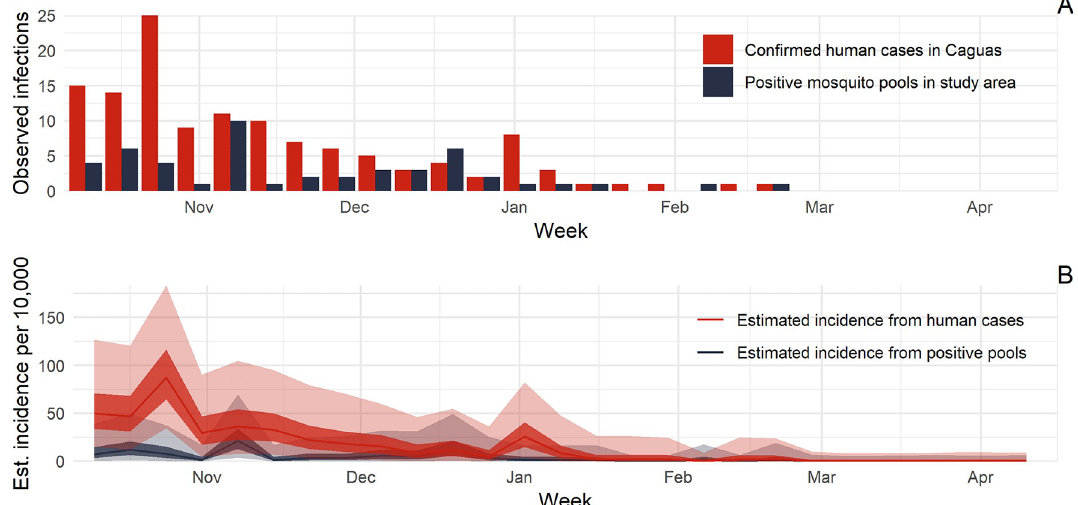
Fig 4. Time series relationship between the actual number of positive mosquito pools and human cases in Caguas, Puerto Rico, and estimated incidence rate of human infections. Panel A shows the actual number of ZIKV positive mosquito pools (navy bars) in the Caguas study area and confirmed human cases (red bars) in Caguas municipality from October 10, 2016, to April 16, 2017. In Panel B, we used the model to estimate the incidence rate of human infections from the number of positive mosquito pools (navy line) and the number of confirmed human cases (red line). The dark bands represent 50% credible intervals (CI), whereas light bands represent 95% CI for the estimated incidence of population infections.